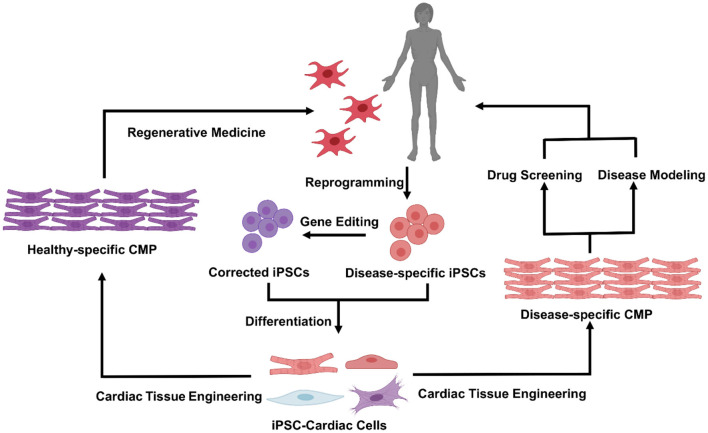
Cardiac tissue engineering and its applications. Patient specific iPSC can be derived by reprogramming of somatic cells from the patient, in healthy vs. diseased states, and used to generate a variety of functional cardiovascular cells. Incorporation of cells within specifically tuned 3D biomaterial systems will enable fabrication of the human cardiac muscle patch (hCMP) that could be used either in a variety of in vitro applications [drug screening and disease modeling (Right)], or as cardiac patch for in vivo regenerative therapies (Left).